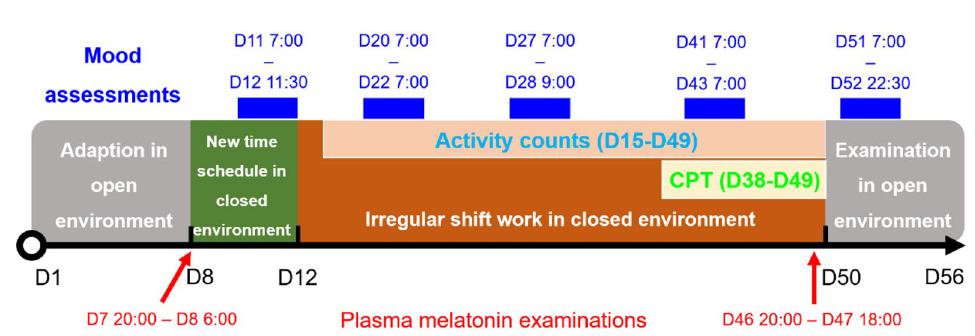
Figure 7. The experimental procedure and times of biological measurements from D1 to D56 (The figure was generated by PowerPoint 2019, URL: https:// www. micro softs tore. com. cn/ softw are/